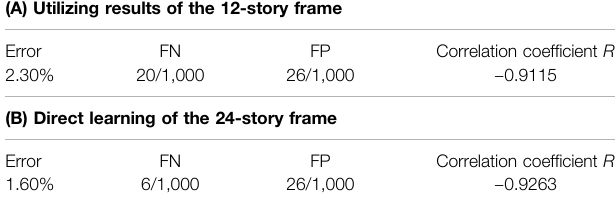
TABLE 6 | Machine learning results of 24-story frame. (A) Utilizing results of the 12-story frame Error FN FP Correlation coef fi cient R 2.30% − 0.9115 (B) Direct learning of the 24-story frame Error FN FP Correlation coef fi cient R